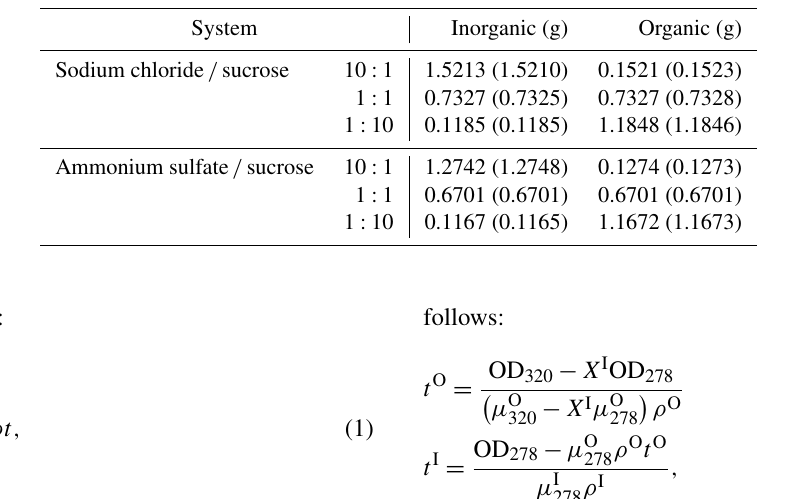
Table 1. Calculated masses of each compound needed to make 100mL of solution. Measured masses in